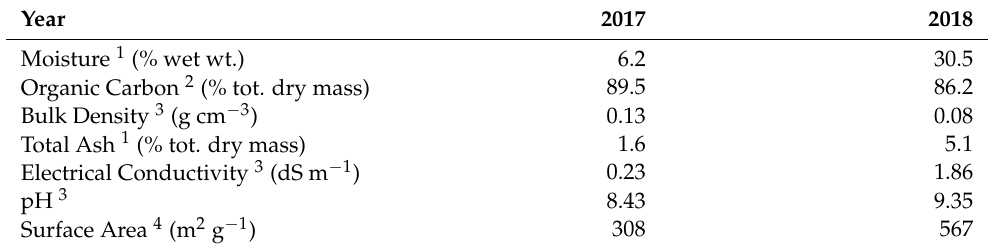
Table 1. Chemical and physical properties of biochar produced from lodgepole pine feedstock.